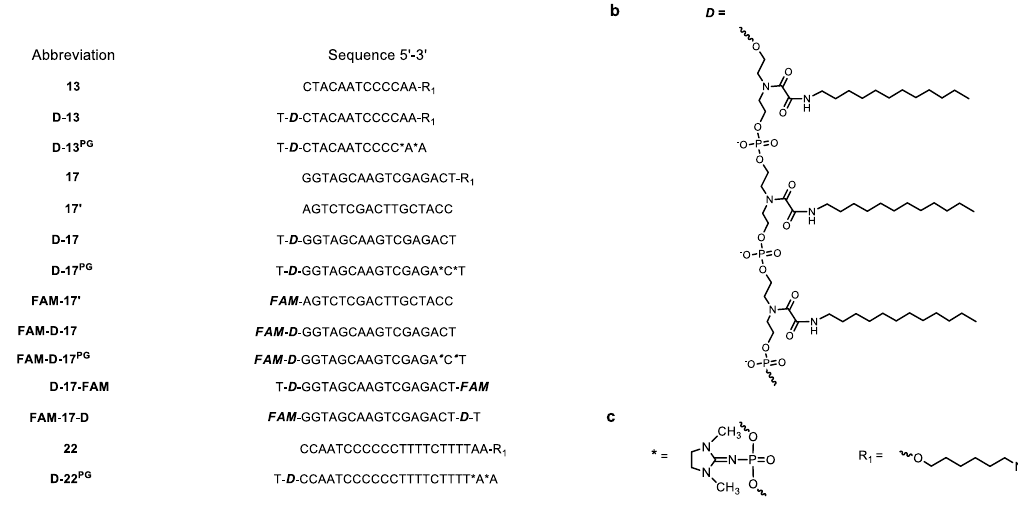
Figure 1. The sequences of oligonucleotides and their conjugates studied in this work ( a ), the structure of “like-a-brush” dodecyl-containing non-nucleoside backbone part of dodecyl oligonucleotide conjugates (DOC) ( b ). All oligonucleotides are deoxy. D-13 PG , D-17 PG , FAM-D-17 PG , D-22 PG are oligodeoxynucleotides partially substituted with phosphoryl guanidine groups (PG); * indicated a position of PG modification, R 1 is the linker with the terminal amino group protecting 3’-end of indicated oligomers from nuclease degradation ( c ). Here, 6-carboxyfluorescein (FAM) is represented 6-carboxyfluorescein residue (See Section 2.3). During post-chromatographic purification, dodecyl-containing oligonucleotides (especially D-17, D-17 PG , and FAM-D-17 PG ) tended to aggregate, which resulted in significant salting-out of the conjugates at millimolar range concentrations used in the experiments.